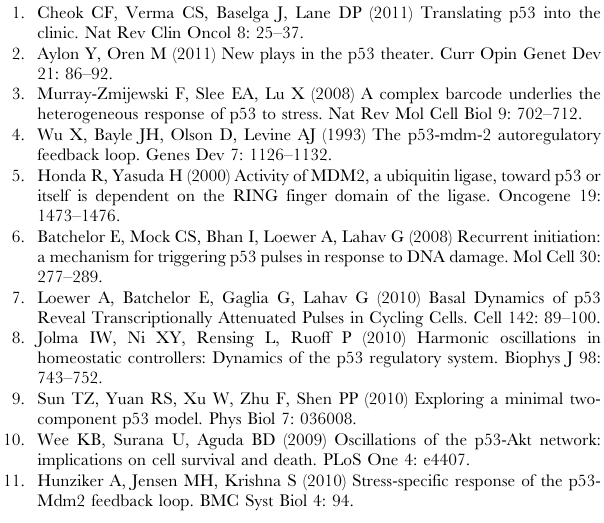
Figure S3 Representative dynamics of p53 under nonstressed conditions. (TIF) Figure S4 Representative dynamics of DSB repair process and associated dynamics of p53 and p21 . DSB (violet), p53 (black) and p21 (grey). (TIF) Figure S5 Schematic representation of DSB repair module and step size control. D t: step size in DSB repair module. t : step size in t -leap method. (Note that even the smallest t is longer than D t= 0.01). Black dots denote spontaneous DSBs. (TIF) Figure S6 The time rescaling process during cell cycle synchronization. Dashed line indicates cell division. Table S1 Ordinary differential equations for the model. Table S2 Model parameters and